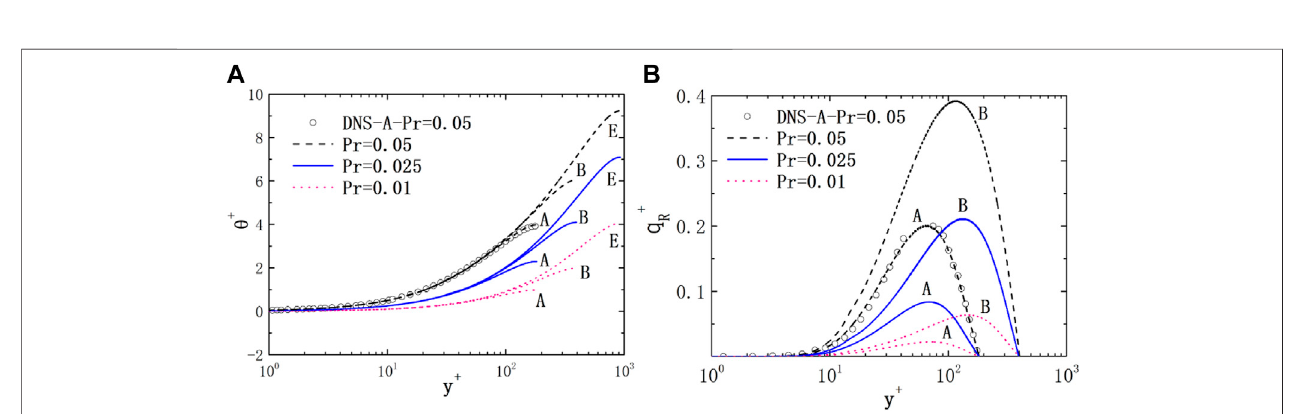
FIGURE 4 | Non-dimensional temperature and heat fl ux of the plane for Pr = 0.025. (A) temperature; (B) heat fl ux.